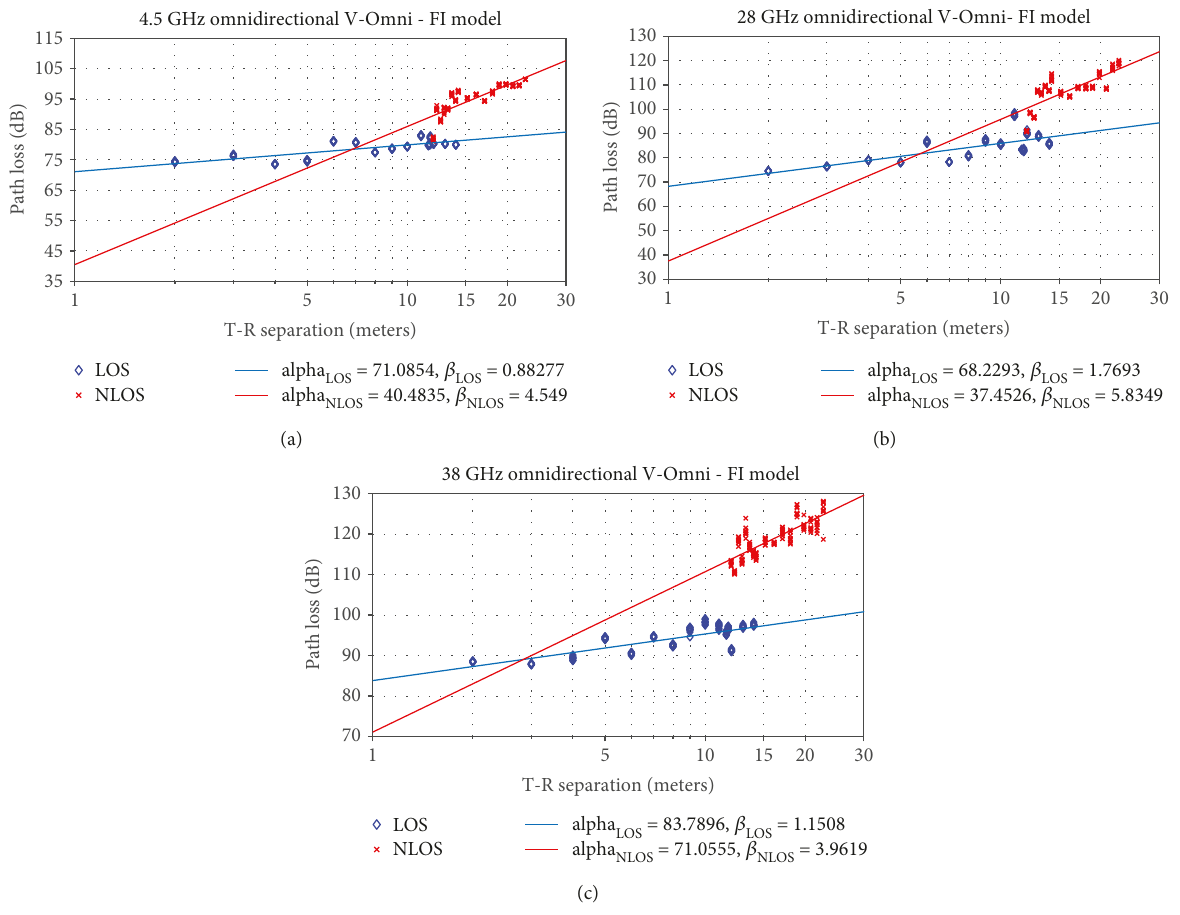
Figure 7: FI path loss model for omnidirectional V-Omni for LOS and NLOS (a) 4.5GHz, (b) 28GHz, and (c) 38GHz. Table 3: FI path loss model parameters for LOS and NLOS, at 4.5GHz, 28GHz, and